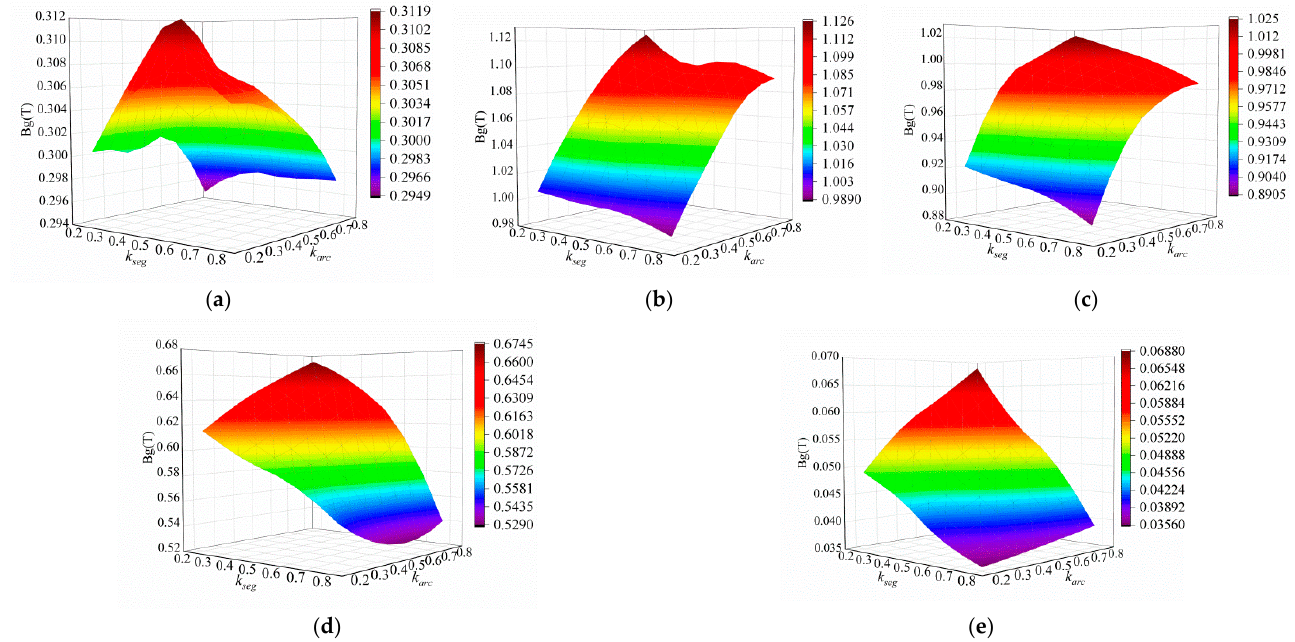
Figure 9. The influence of cross-shaped flux-barriers parameters on flux density in each region of air-gap: ( a ) region C1; ( b ) region C2; ( c ) region C3; ( d ) region C4; ( e ) region C5.